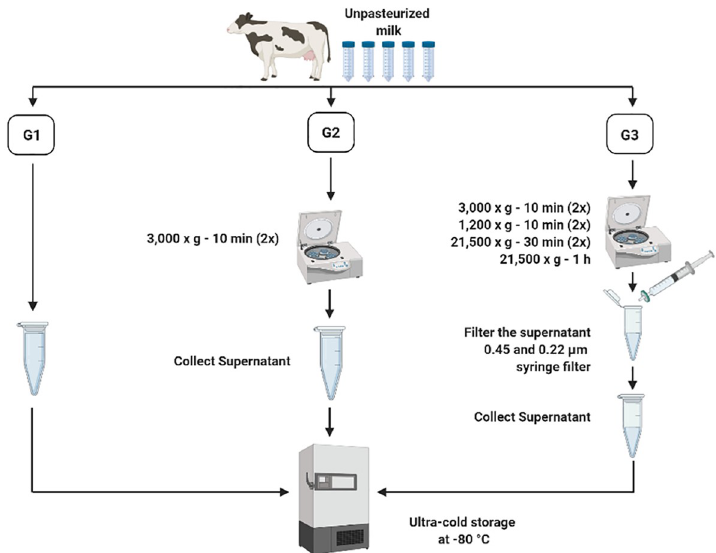
Fig 1. Pre-processing of bovine colostrum prior to long-term storage at -80˚C. Group (G)1: whole milk frozen immediately upon collection and processed post-thaw. G2: Whole milk processed to remove fat globules and cream prior to ultracold storage. G3: Whole milk processed to remove fat globules, cream, milk cells, and casein proteins prior to ultracold storage.